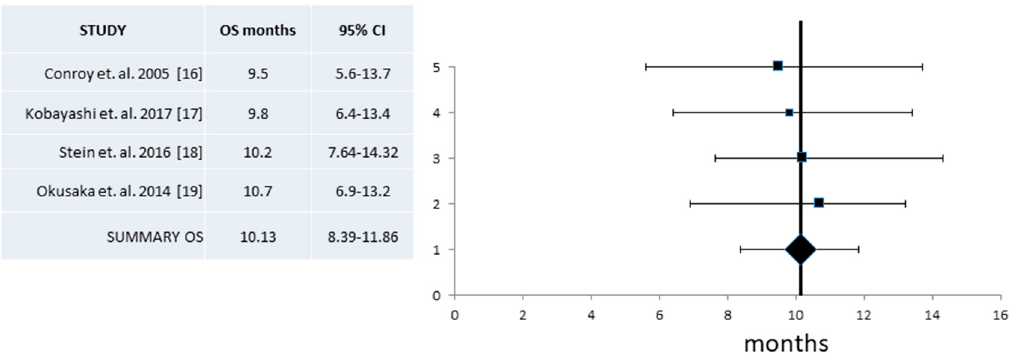
Figure 9. Pooled analysis of Overall Survival (OS) and 95% Confidence Intervals (CI) from phase II trials. Four trials with a total of 127 patients that provided information for the OS were included. Pooled OS derived was 10.13 months (95% CI 8.4–11.9 months).